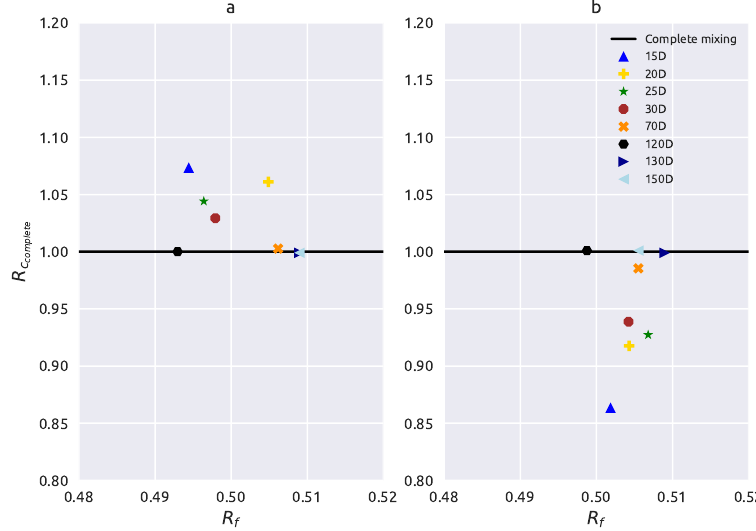
Figure 5. Influence of Tee junctions distance on complete mixing—the relationship between inlet flow ratio R f and outlet conductivity ratio R c : ( a ) Configuration S ( b ) Configuration U. complete